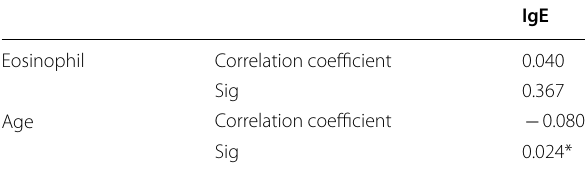
* Pearson correlation is significant at the 0.05 level